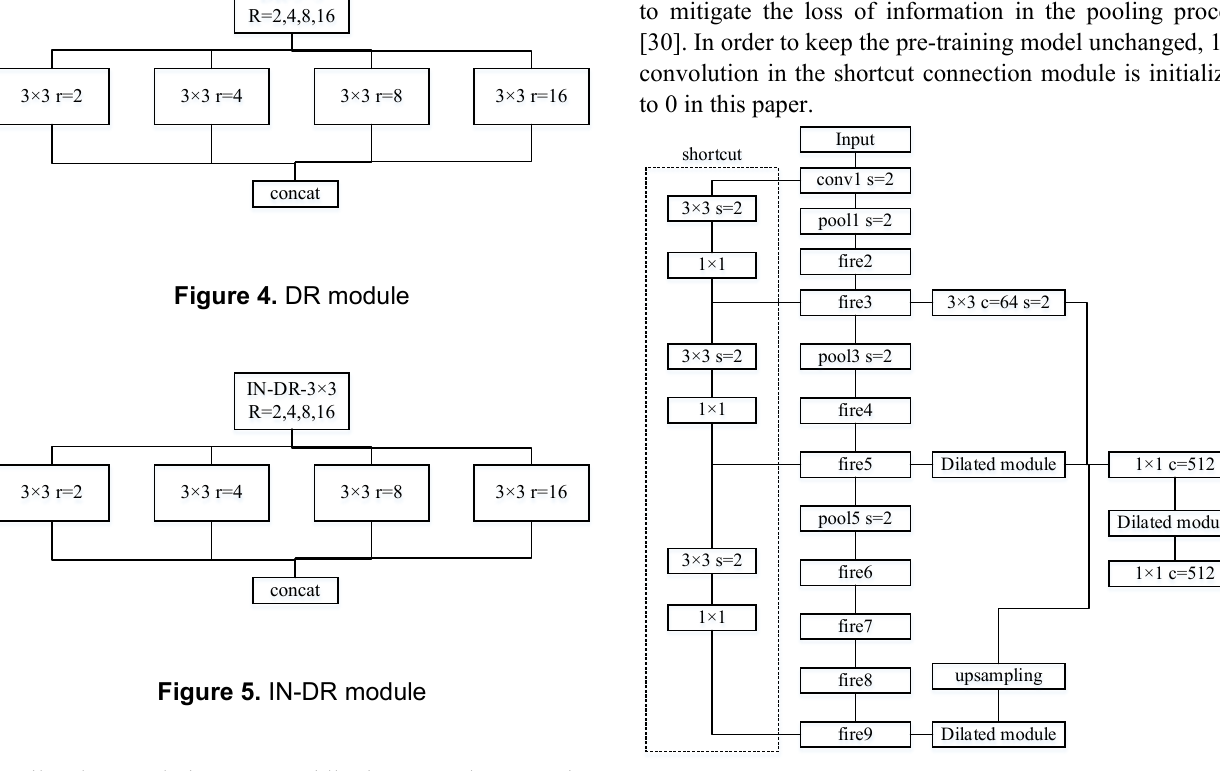
Figure 7. Multi-scale information